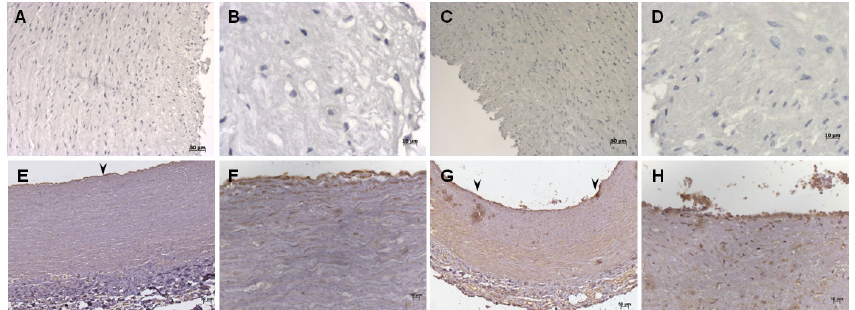
Figure 1. CD100 is expressed only in endothelia of normal coronary and carotid arteries. CD100 labeling (E-H) and negative controls (A-D) in normal carotid (A, B, E, F) and coronary (C, D, G, H) artery tissue sections by immunohistochemistry. Positive CD100 staining was observed only in endothelia of normal arteries (arrowheads). Scale bars: 10µm ( A , E , C and G ) and 50µm ( B , F , D and H ).